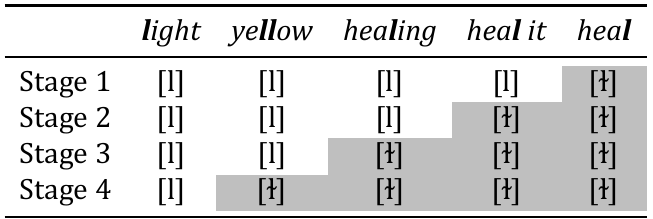
Table 5: Dialects at different stages show how /l/-darkening advances through the